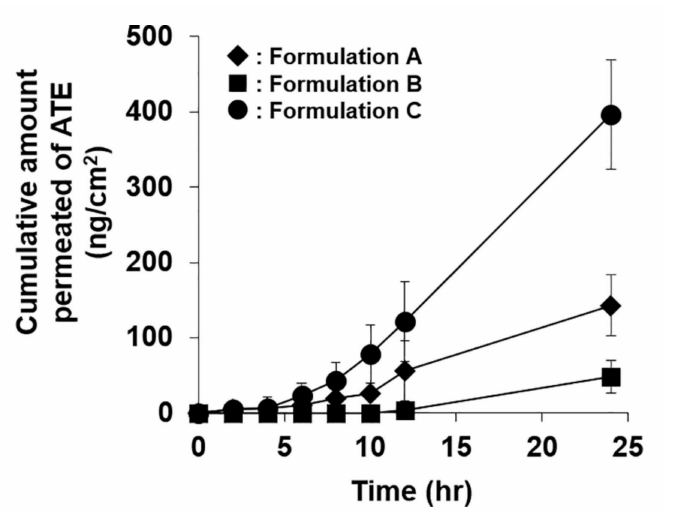
Figure 2. Transdermal permeation profile of atenolol (ATE) from each formulation (bars represent standard deviation, n = 4). A: pure ATE saturated suspension; B: ATE-Urea (1:8) saturated suspension; C: ATE-Urea (1:8) co-amorphous based supersaturated formulation. Figure adapted with permission from [15], Elsevier,